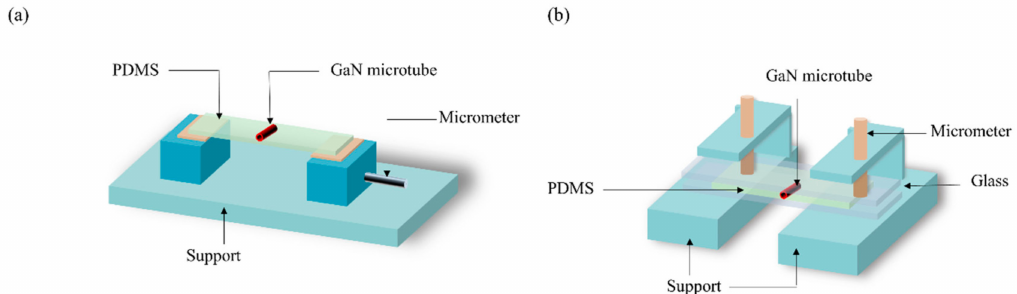
Figure 2. Schematic diagram of the experimental setup for the strain test: ( a ) tensile force in the X and Z directions and ( b ) compressive force in the Y